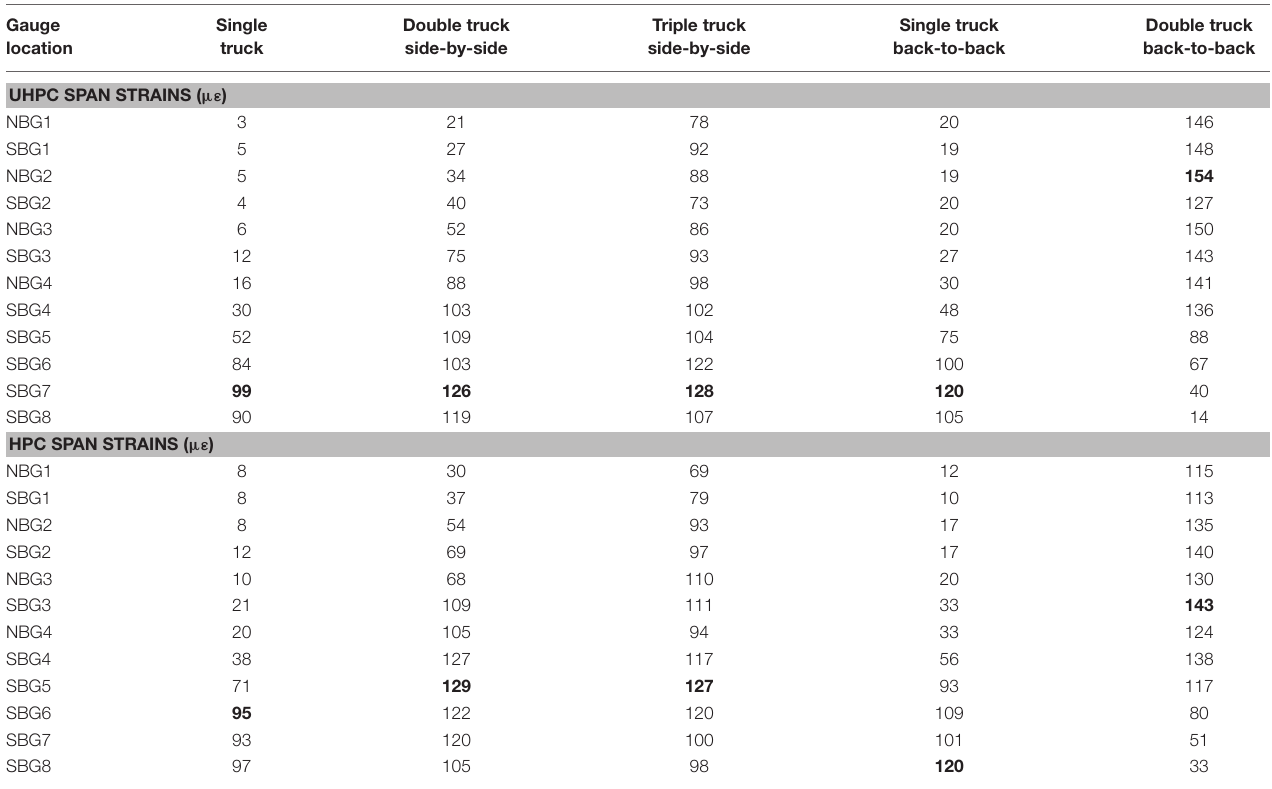
TABLE 8 | Maximum stage 2 load test strains for UHPC and HPC. Gauge